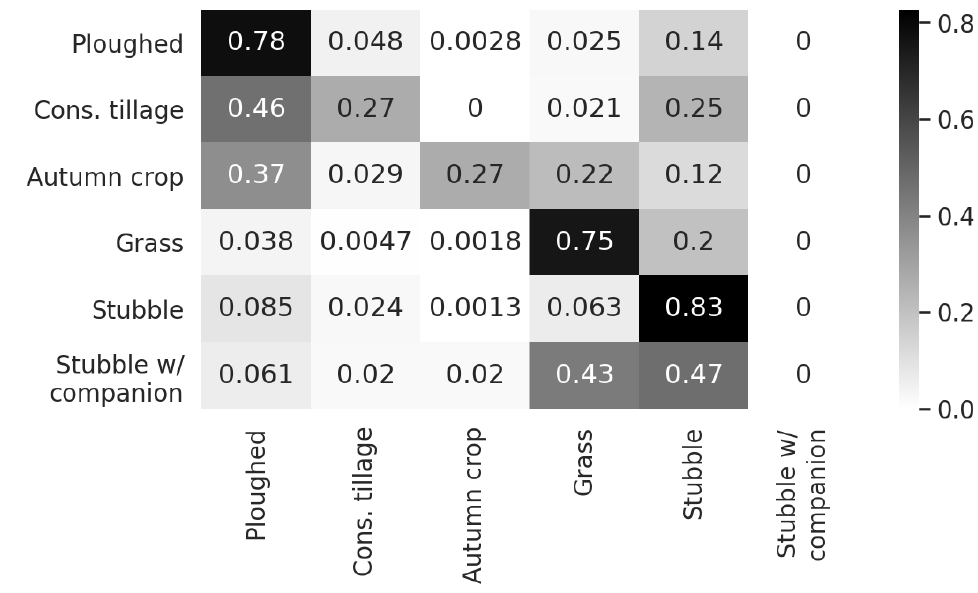
Figure 11. Normalized confusion matrix for classification of fused SAR + MSI image objects for the full set of annotated